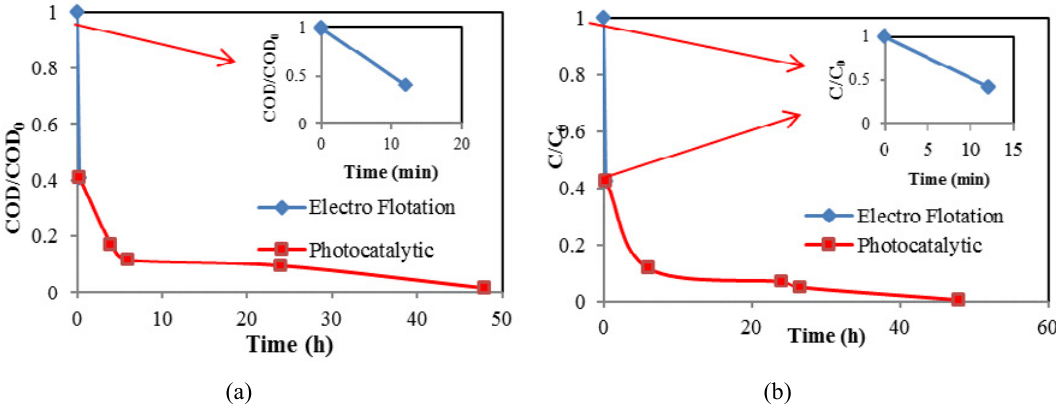
Fig 5. (a) SDBS concentration to initial SDBS concentration ratio) vs. time (b) COD/COD